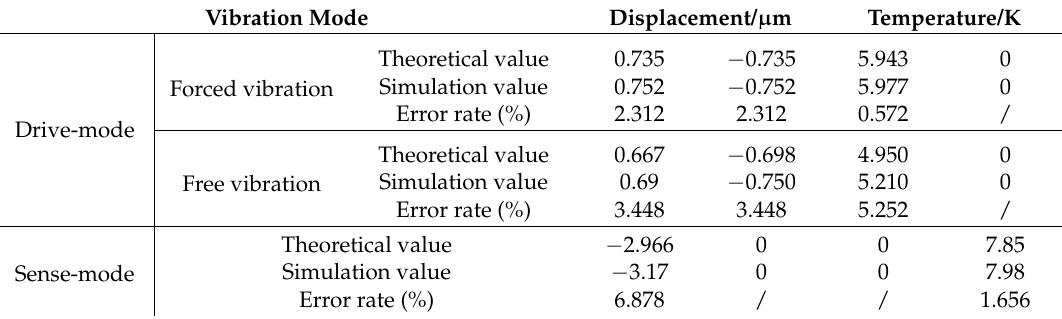
Figure 12. The path analysis results of temperature and displacement variation. Table 2. Field quantities simulation and analytical comparison results for vibration at drive-mode and sense-mode.